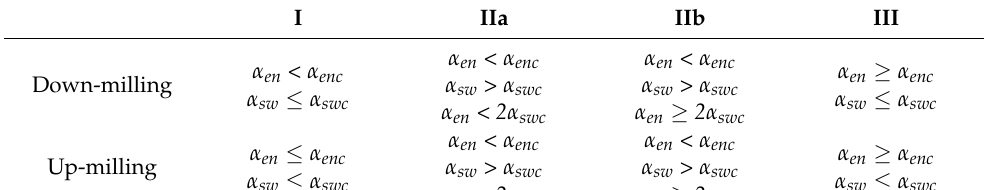
Table 1. Single flute F type conditions.